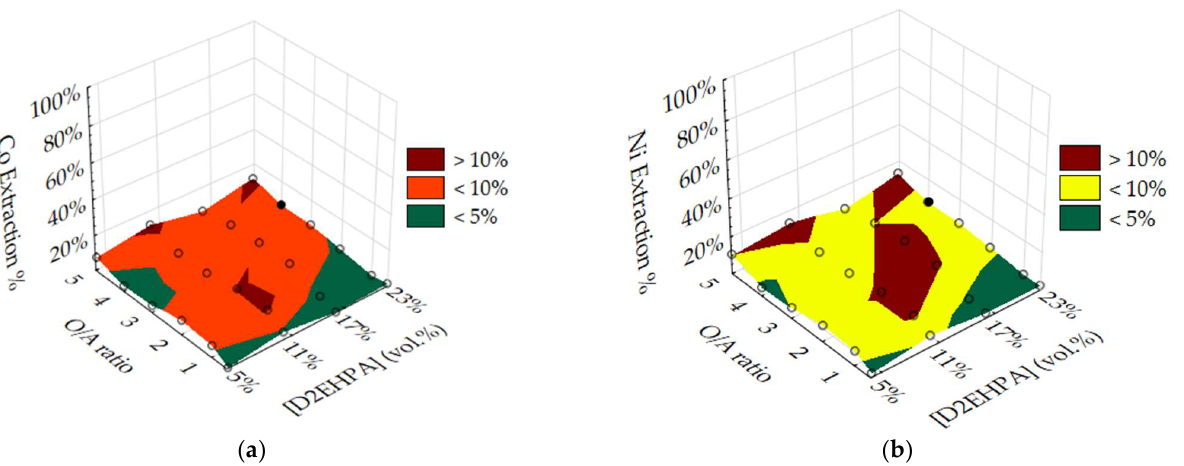
Figure 8. ( a ) Co and ( b ) Ni co-extraction as a function of O/A ratio and D2EHPA concentration at pH 5.5.